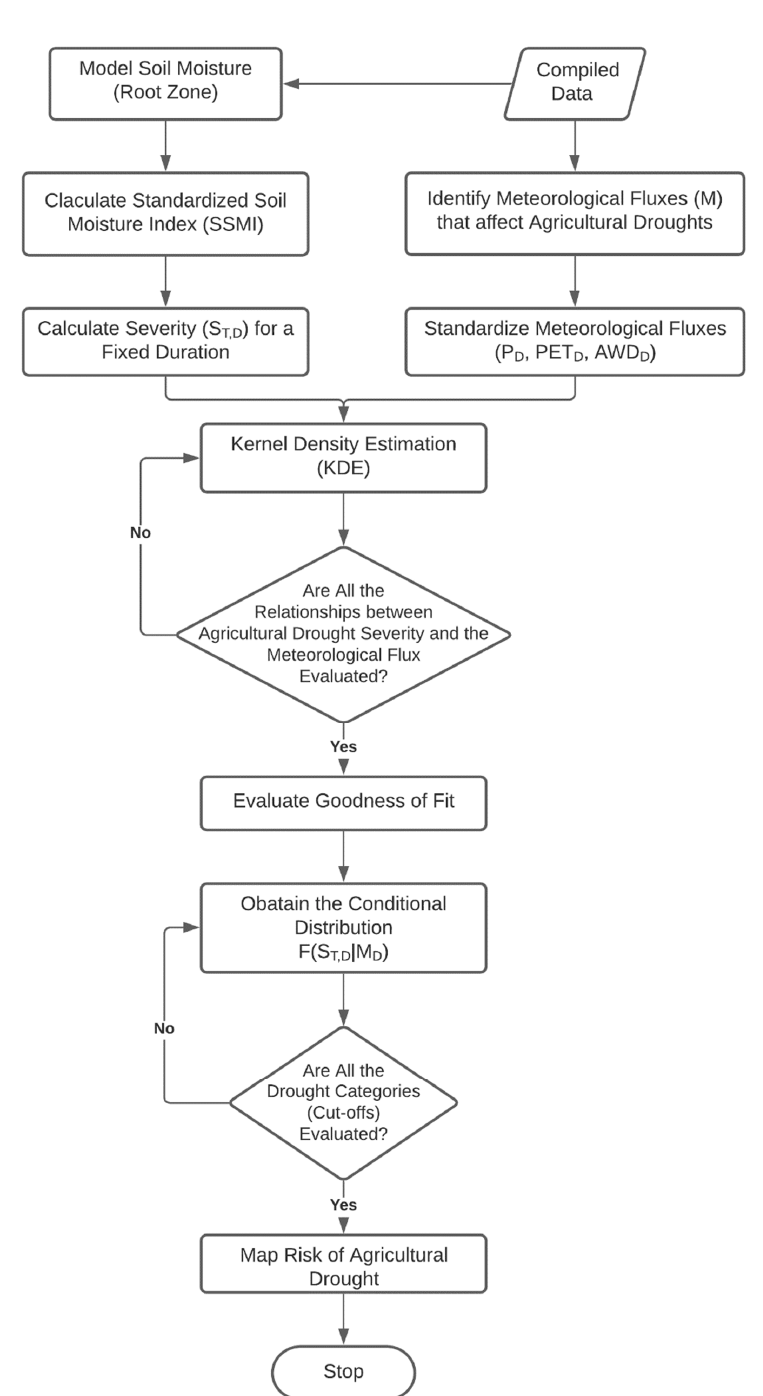
Figure 1. Flow chart for the proposed risk assessment methodology.